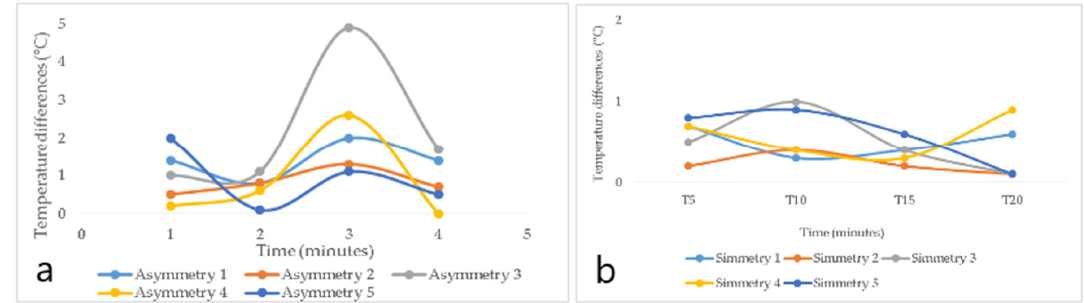
Figure 8. Graph of behavior of minimum temperature differences of the palm of the hand from the tolex area. ( a ) corresponds to subjects with asymmetries. ( b ) represents subjects with symmetries. The minT R point represents the minimum temperature of the right wrist (palm side), and the minT L point corresponds to the minimum temperature of the left wrist (palm side). In Figure 9, there were fifteen cases with temperature difference between the minT